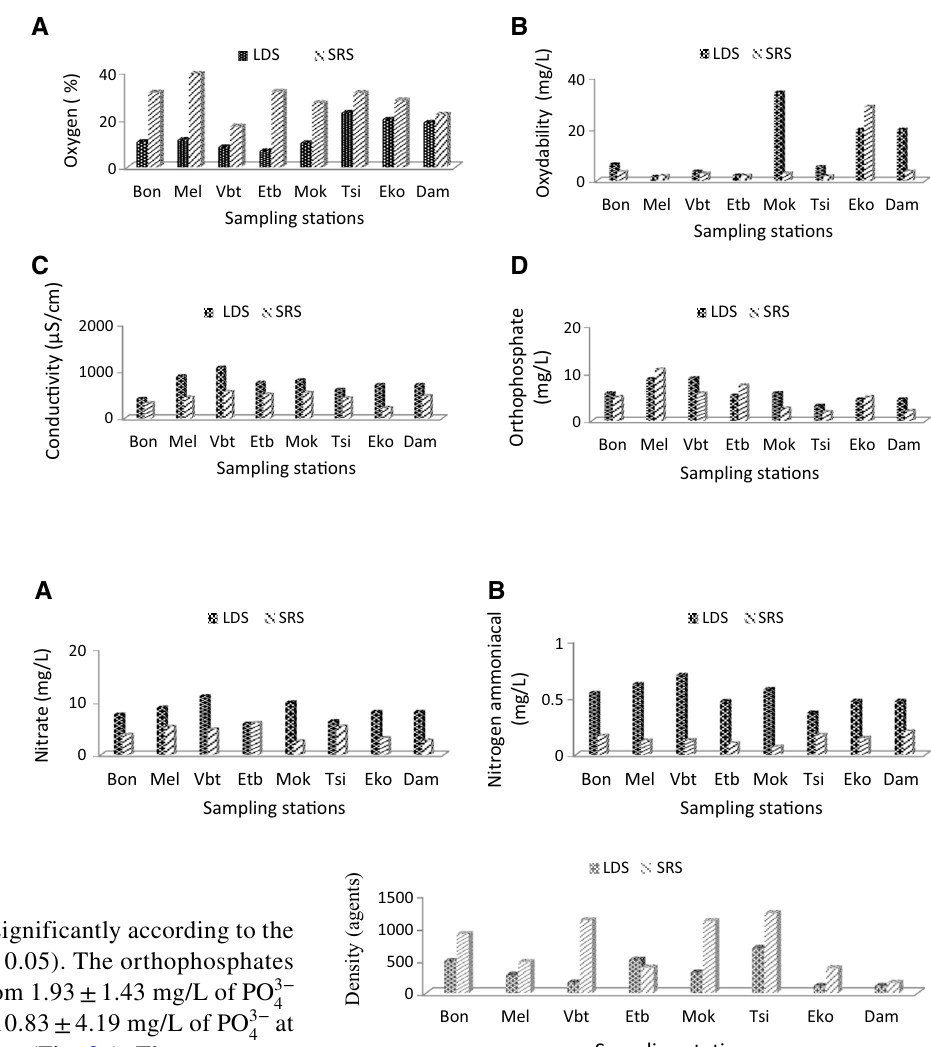
Fig. 4 Seasonal variation of the average density of eggs and the